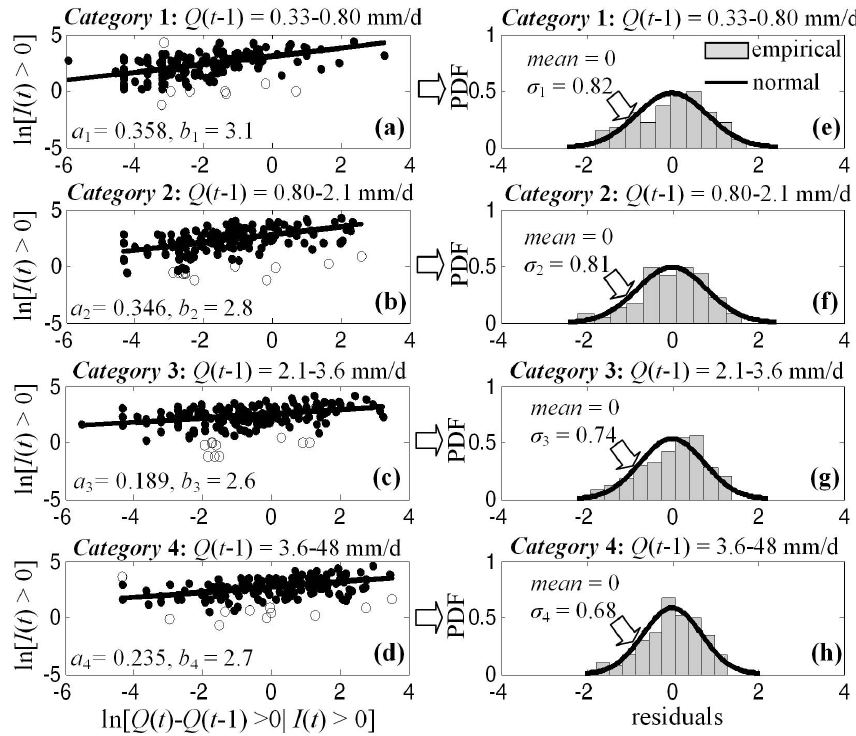
Fig. 7. Same as Fig. 6 but using daily rainfall intensities from the location of the dam (point B in Fig. 2) for the period 1 October 1974– 30 September 1993 (i.e. 19yr, 641